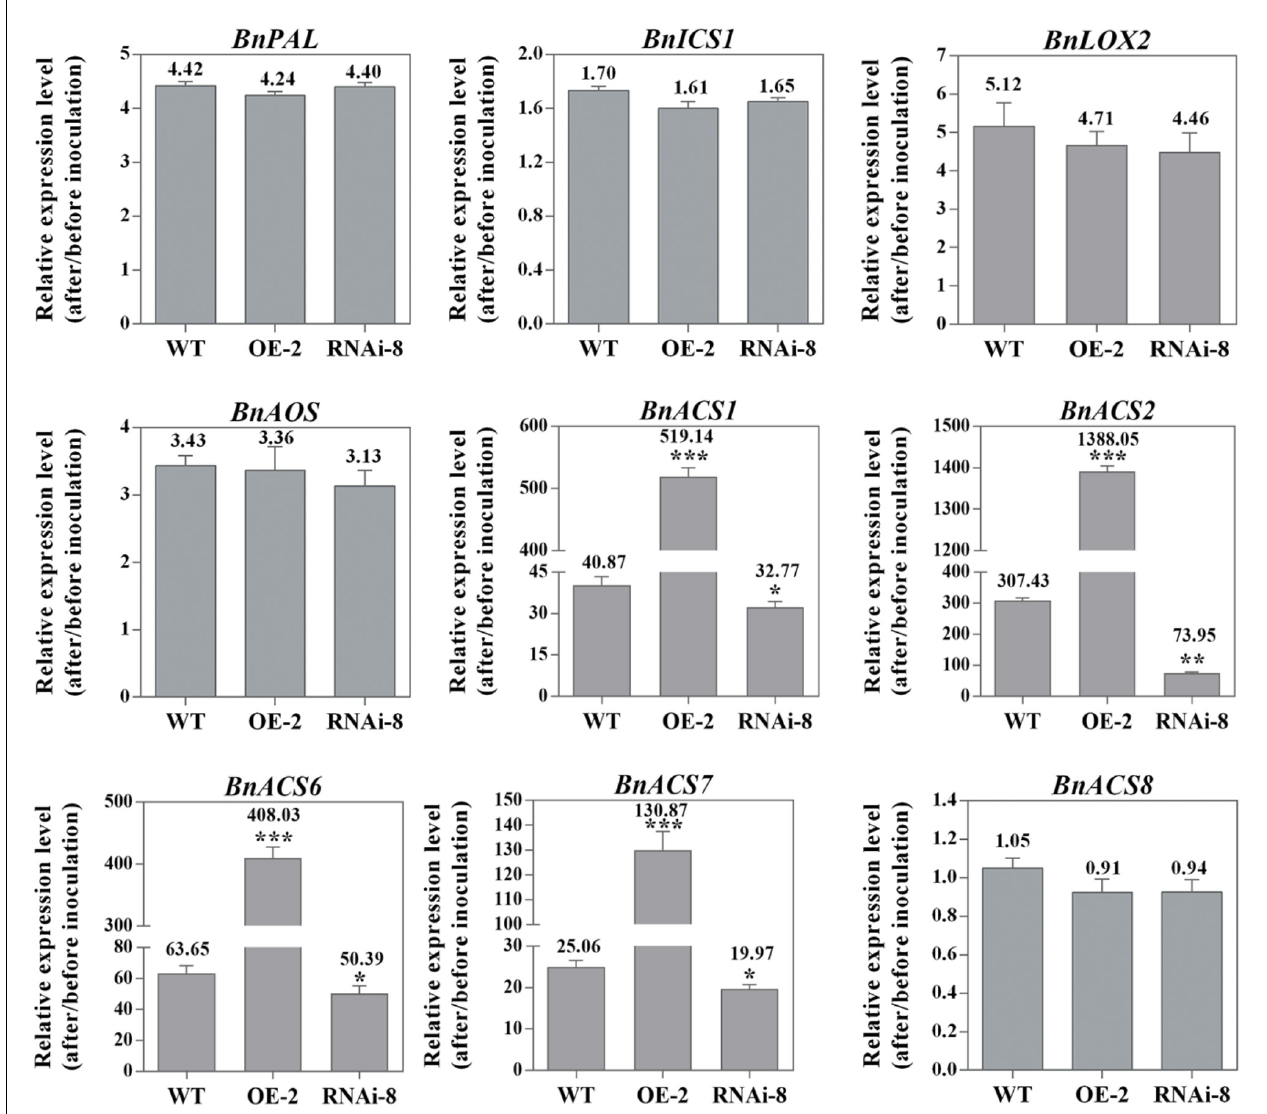
FIGURE 6 | BnaMPK3 differentially regulates the expression of SA, JA, and ET biosynthesis genes in response to S. sclerotiorum infection. Changes in expression of the genes involving in SA, JA, and ET biosynthesis in the BnaMPK3- overexpressing transgenic line 2 (OE-2), the untransformed wild-type (WT) control and the BnaMPK3- RNA-interfering transgenic line 8 (RNAi-8) plants after 24 hpi. Samples were collected at the indicated time for total RNAs isolation. Expressions of these genes were quantified by real-time PCR, and then change of gene expression (folds of change relative to the level before inoculation) was calculated. Values are means of three replicates, and error bars indicate standard deviations. The significances of the gene expression differences between each transgenic line and WT are indicated (Student’s t -test, ∗∗∗ P < 0.001, ∗∗ 0.001 < P < 0.01 or ∗ 0.01 < P < 0.05). These experiments were repeated with the BnaMPK3- overexpressing lines 6 and 8, and the BnaMPK3 -RNAi lines 16 and 19, and results are